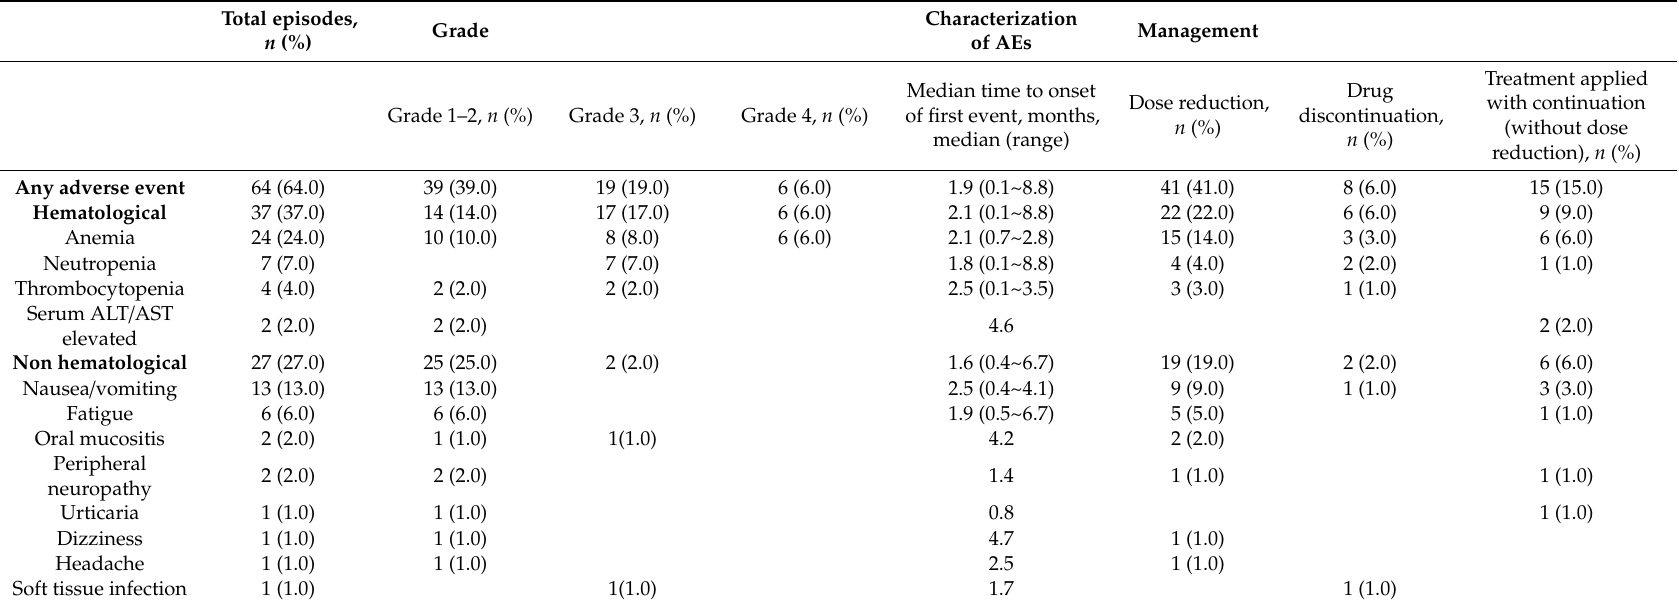
Table 3. Adverse events